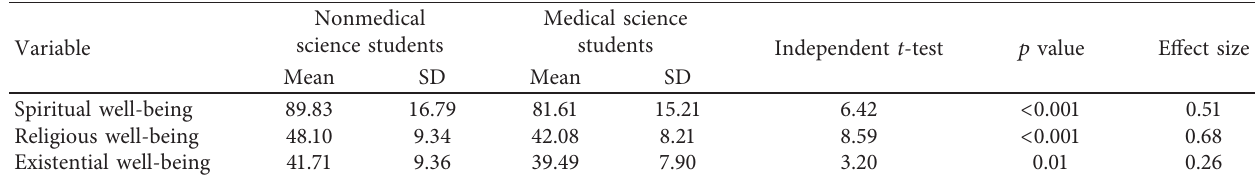
Table 2: Comparison of scores of spiritual well-being and its dimensions among nonmedical and medical science